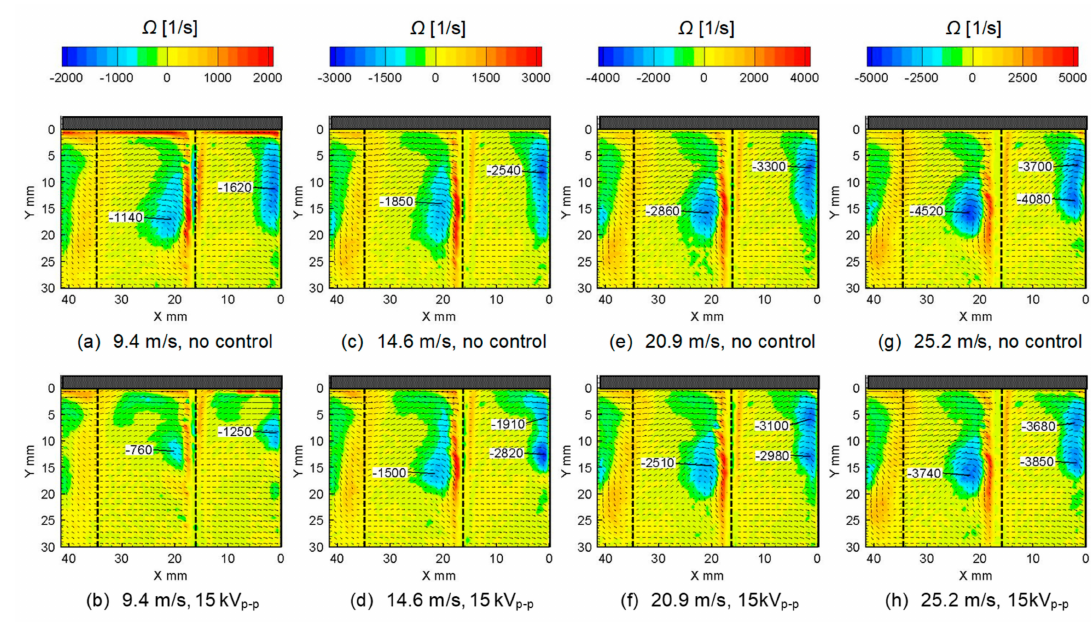
Figure 24. Vorticity distributions at the outlet of the linear turbine cascade at various freestream